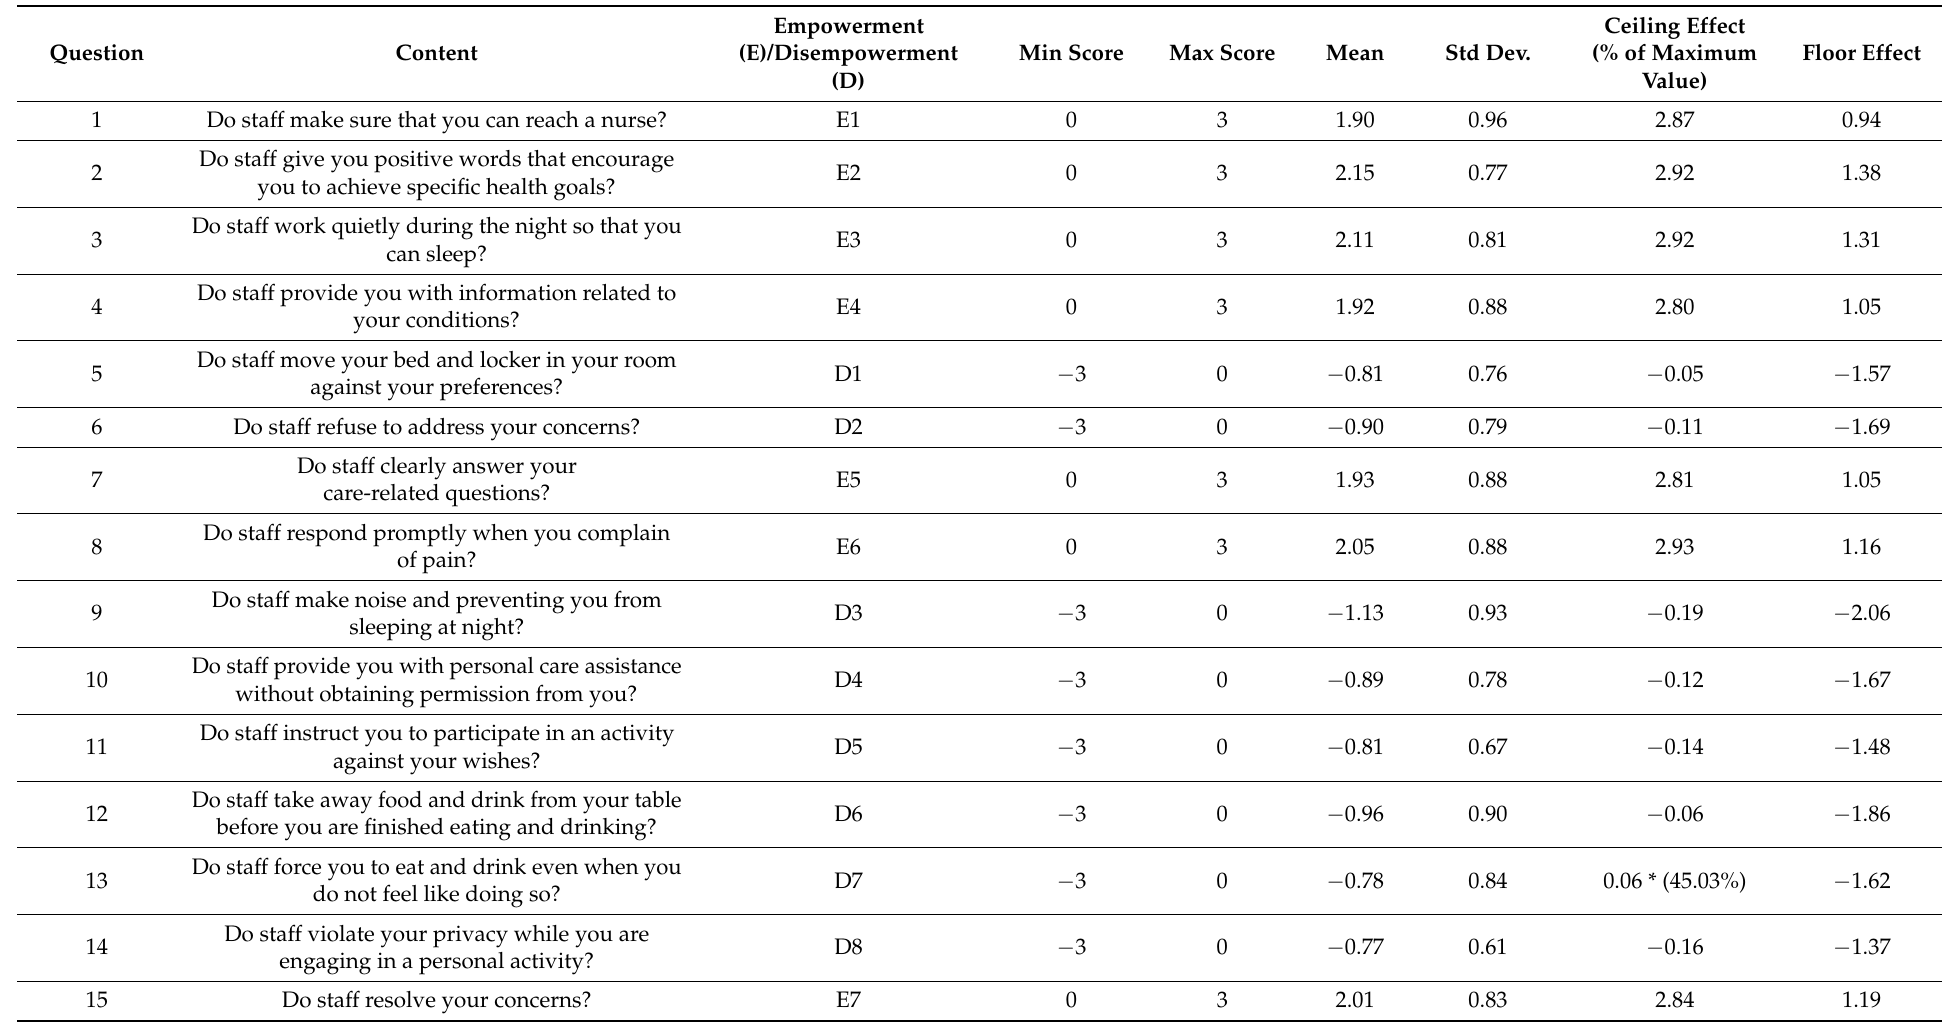
Table 2. Measurement results of the